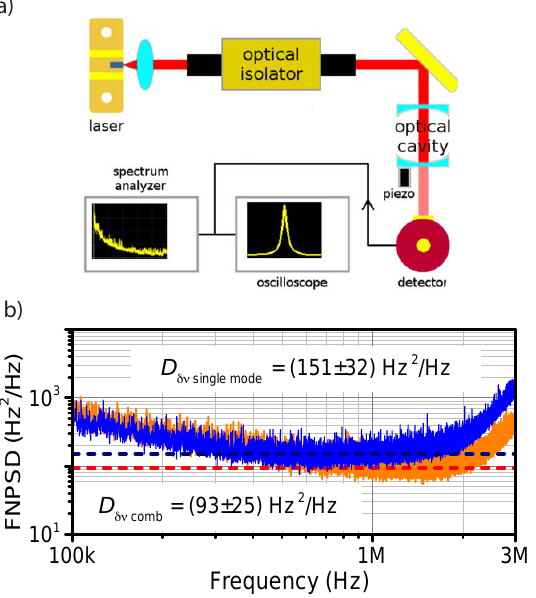
Figure 17: Schawlow–Townes linewidth of QCL combs. a Experimen- tal setup used to measure the FNPSD of the QCL comb. The main optical components include the QCL laser, the optical isolator, the high-finesse optical cavity, and the high-sensitivity MCT detector. The signal is processed by a high-sampling-rate oscilloscope. b Zoom of the flattening portion of the FNPSD of the QCL comb around 1MHz, corresponding to the Schawlow–Townes limit. The spectra are compensated for the FA converter cutoff. The spectra are re- lated to the two operating conditions of the laser: single-mode with P = 15 mW (blue) and comb regime (with all the modes in resonance with the cavity) with P = 25 mW (orange). Results published in